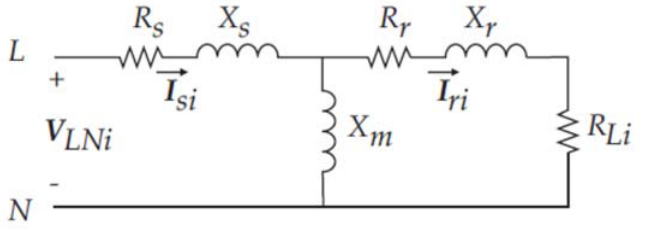
Figure 7. Sequence line ‐ to ‐ neutral circuit model of the induction generator